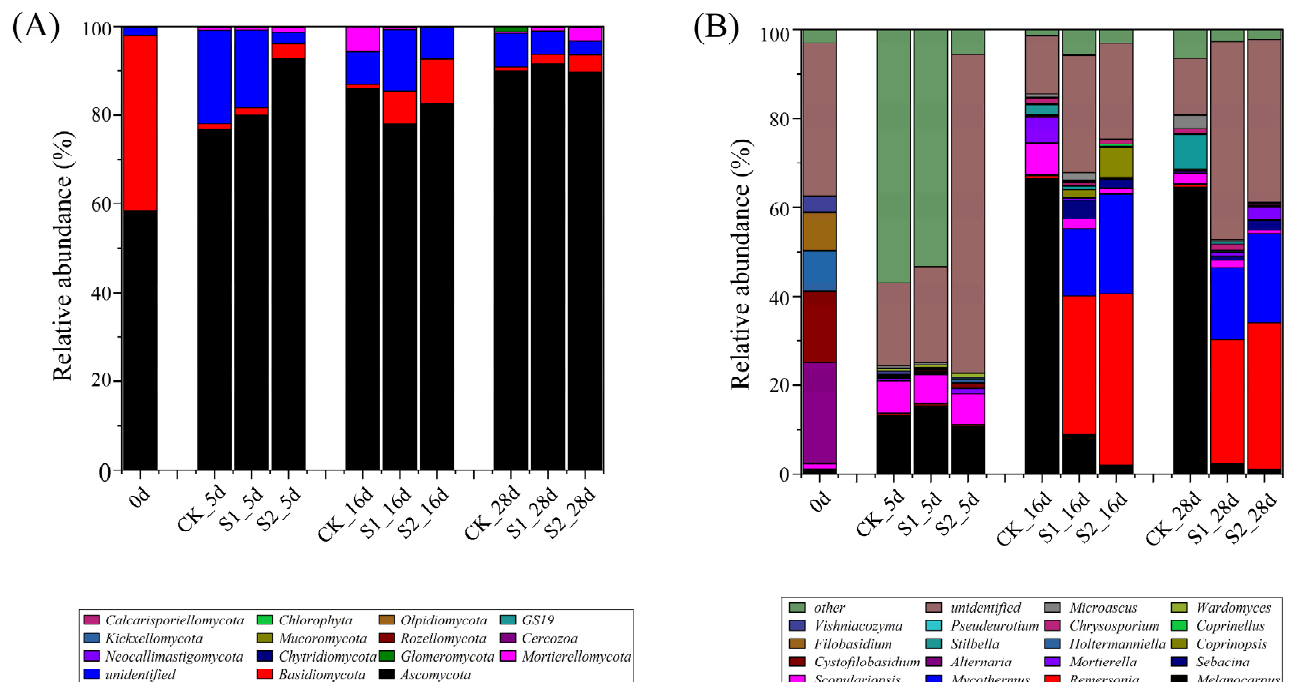
Figure 3. Fungal community structure at the phylum level ( A ), and at the genus level ( B ). Figure 3B shows the variations in the fungal community structure at the genus